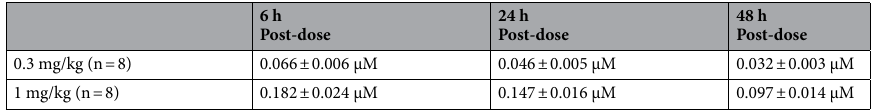
Table 5. Aficamten plasma concentration values at 6-, 24-, and 48-h post-dose following 0.3 and 1 mg/kg doses. Plasma values are expressed as mean ±